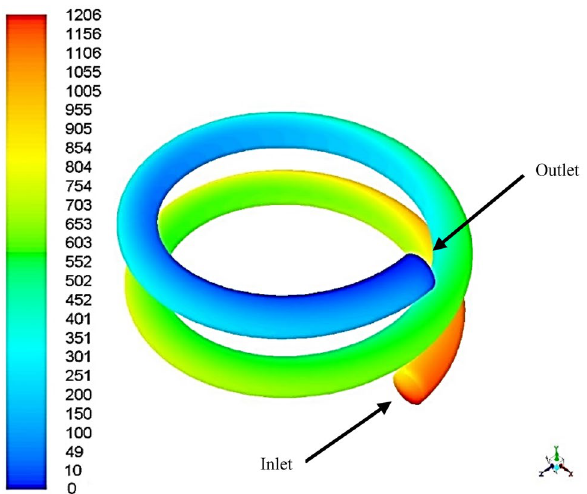
Fig. 5 Pressure [pa] distribution contour